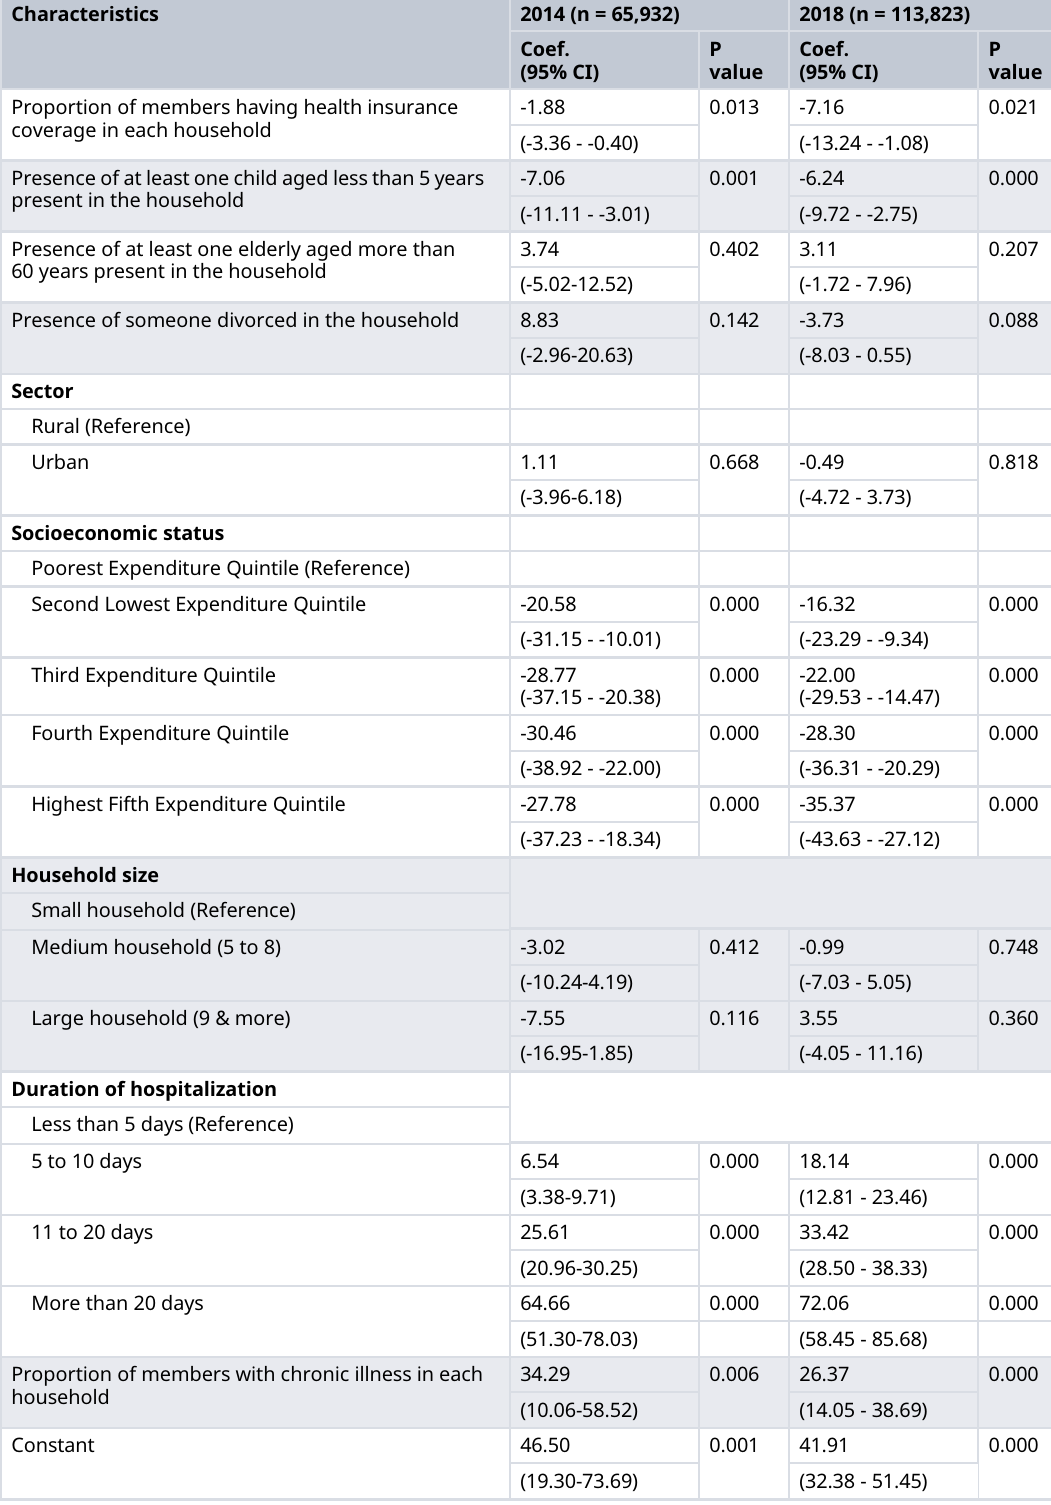
Table 6. Multiple regression for the factors affecting intensity of CHE.